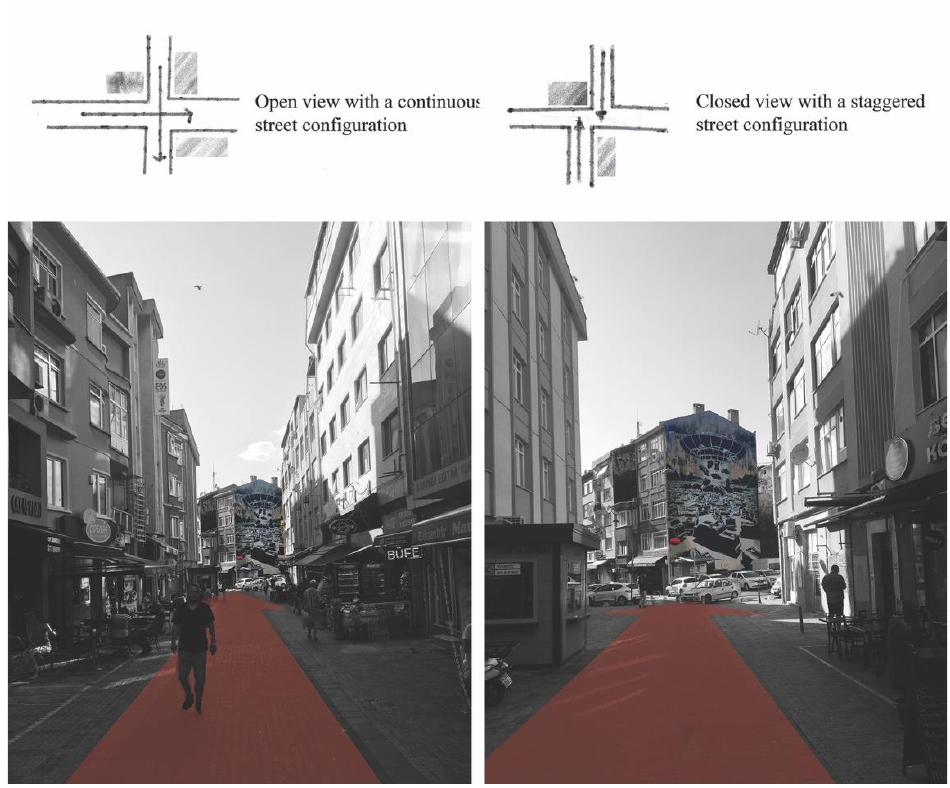
Figure 10 The staggered configuration of the street pattern generates the interrupted view that enables a better perception of the mural if it is located at the terminal point of the view